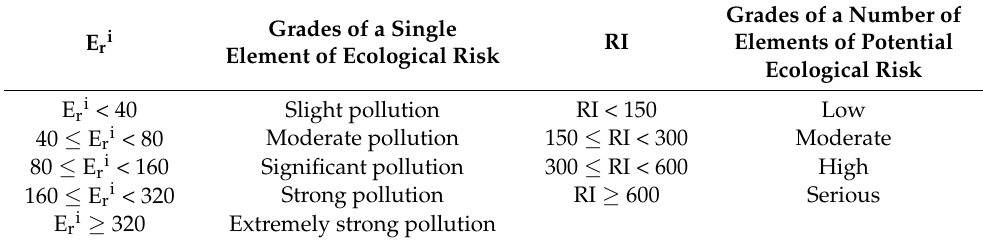
Table 2. Grading evaluation for potential ecological harm.